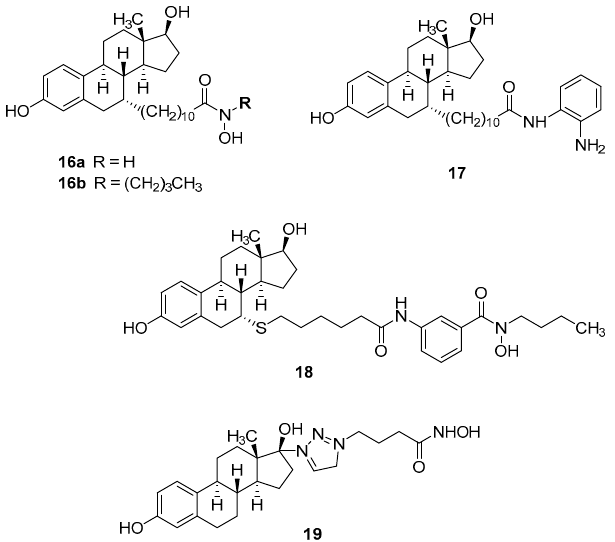
Figure 5. Structures of selected drug conjugates incorporating steroids. Table 4. Pharmacological actions of selected drug conjugates incorporating steroids. Activity at ER α